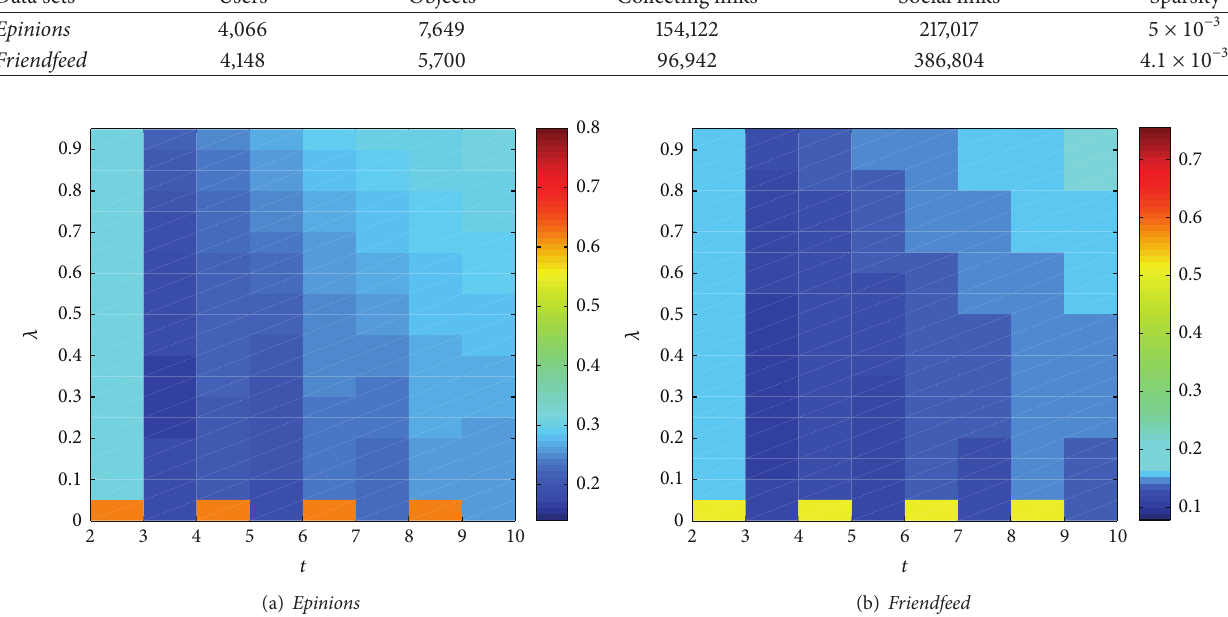
Figure 2: Ranking score values on Epinions and Friendfeed data sets (color